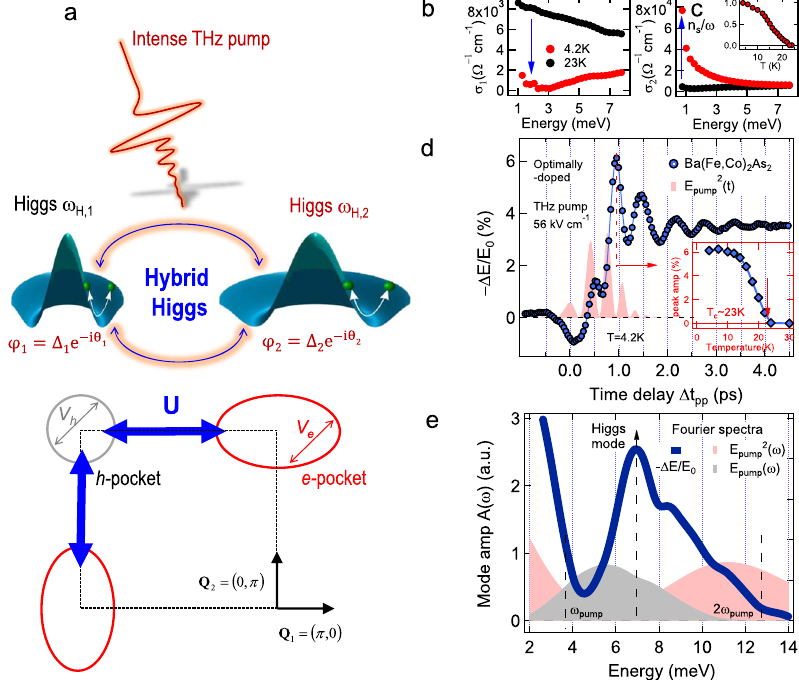
Fig. 1 The 2 Δ SC coherent oscillations detected by two-pulse THz coherent spectroscopy of multi-band FeSCs. a Illustration of coherent excitation of hybrid Higgs mode via THz quantum quench. An effective three-band model has a h pocket at the Γ point and two e pockets at X/Y points, with strong inter- (blue) and weak intraband (gray and red) interactions marked by arrows. b , c Real and imaginary parts of the complex THz conductivity spectra σ 1 ( ω ) and σ 2 ( ω ) in the superconducting (4.2 K) and normal states (23 K) of Ba(Fe 1 − x Co x ) 2 As 2 ( x = 0.08) in equilibrium. Inset of c shows the temperature dependence of the super fl uid density normalized to its value at 4.2 K, n s ( T )/ n 0 , as determined from 1/ ω divergence of σ 2 ( ω ) (blue arrow in c ). d Differential THz transmission Δ E / E 0 (blue circles) measured by phase-locked two-THz-pulse pump – probe spectroscopy at 4.2 K shows pronounced coherent oscillations for a peak THz fi eld strength of E pump = 56 kV/cm. The pink shaded curve denotes the square of the pump THz waveform E 2 . Inset: pump Temperature dependence of the peak amplitude of Δ E / E 0 . e Fourier spectrum of the coherent oscillations in Δ E / E 0 (blue line) exhibits a resonance peak at ~6.9 meV (blue line) and is distinct from both the pump E pump (gray) and pump-squared E 2 (pink) pump